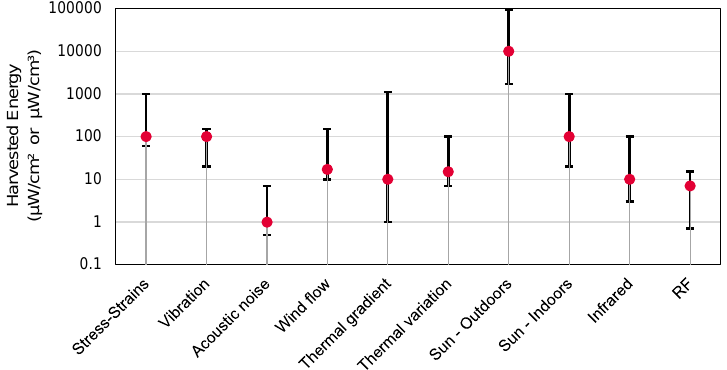
Figure 1. Power comparison of most common EH sources [3]. Typical range and most frequent